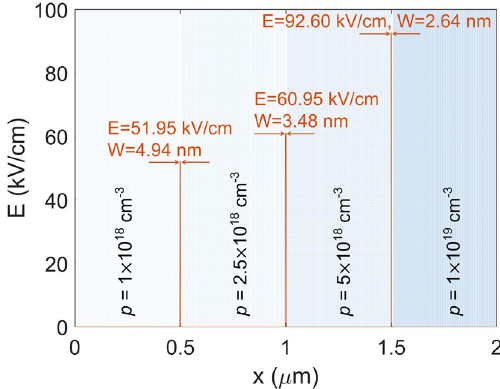
Figure 2. The electric fields generated inside a sample stepwise-doped structure. The lines between adjacent doping layers indicate the strengths of the electric fields in those regions. The widths W of these regions are also labeled.